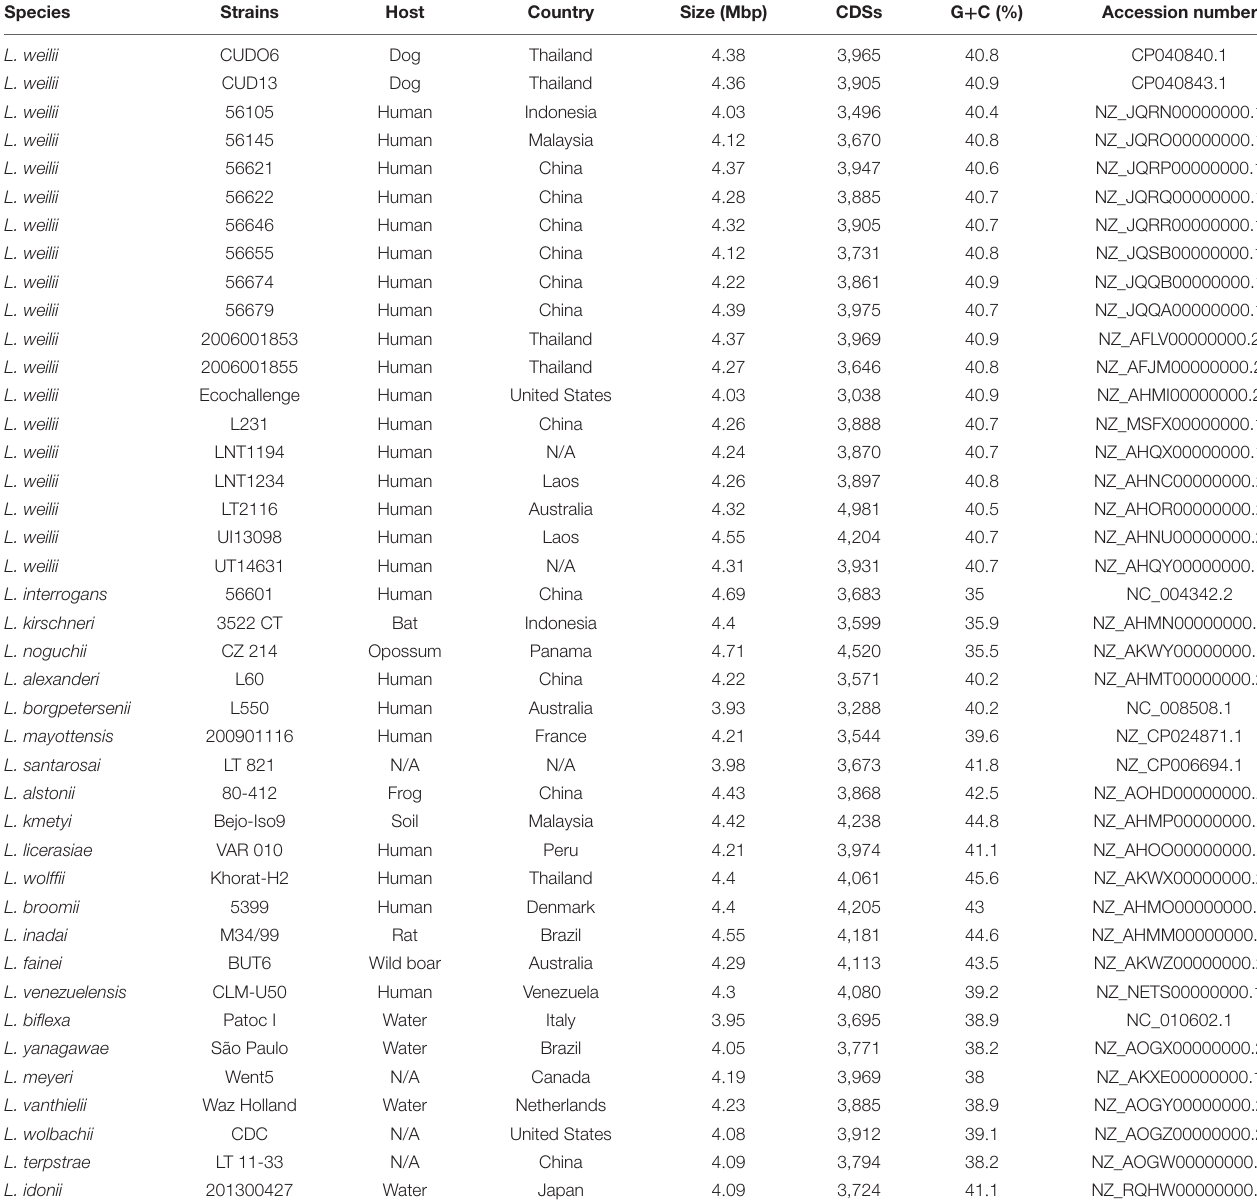
TABLE 1 | Leptospira strains used for analysis in this study. Species Strains Host Country Size (Mbp)